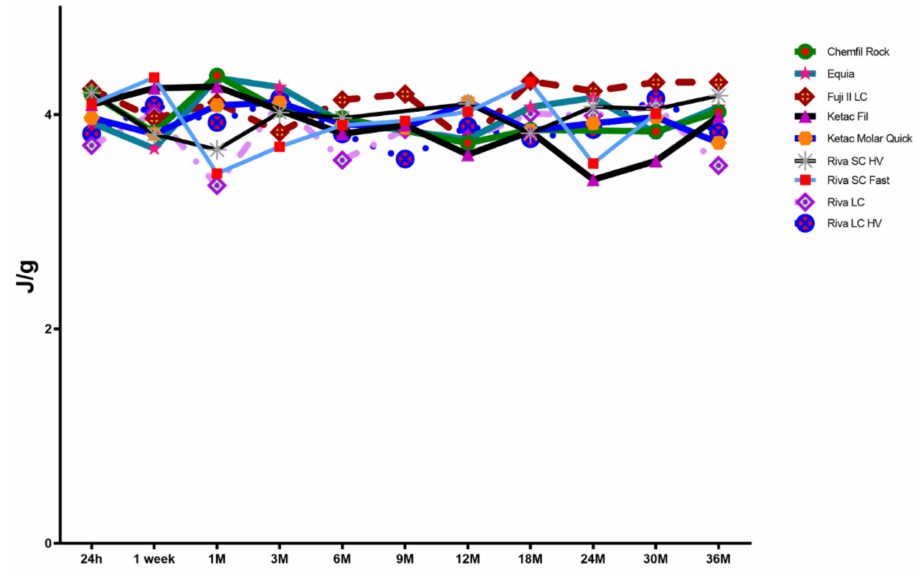
Figure 5. Mean Bound Water Loss Enthalpy (J/g); n =